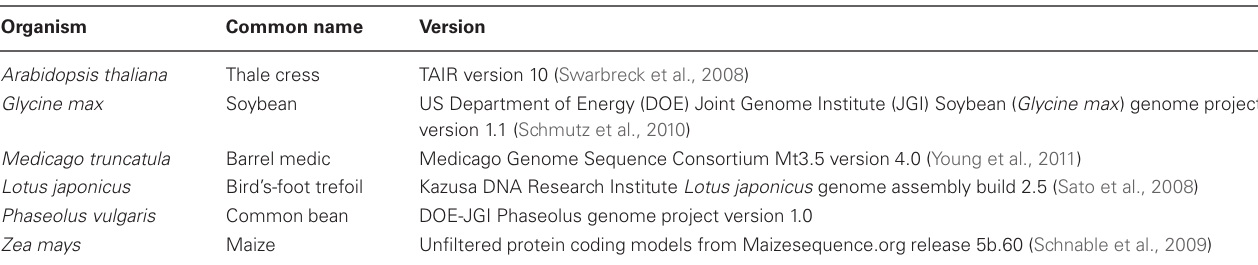
Table 3 | Analyzed plant genomes in version 9.0 of Phytozome. Organism